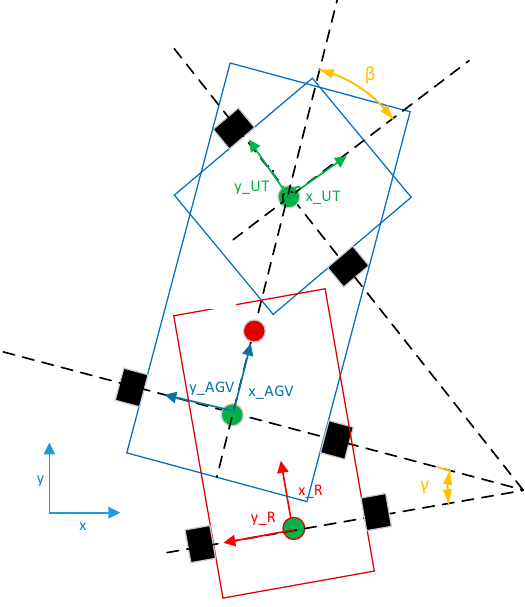
Figure 8. AGV and Trailer scheme.